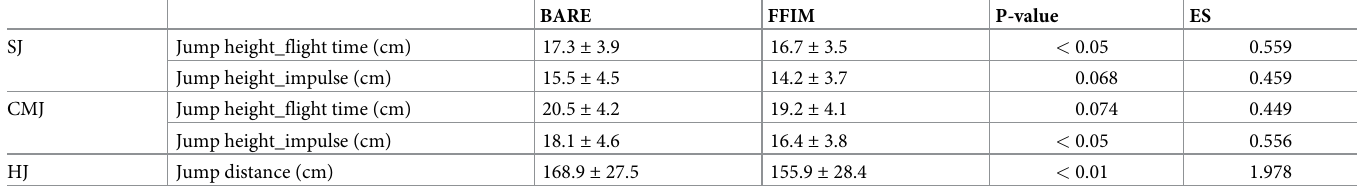
Table 1. Comparison of jump performance during the squat jump (SJ), countermovement jump (CMJ) and horizontal jump (HJ) under barefoot (BARE) and fore- foot immobilization (FFIM) conditions. BARE FFIM P-value Jump height_flight time (cm)